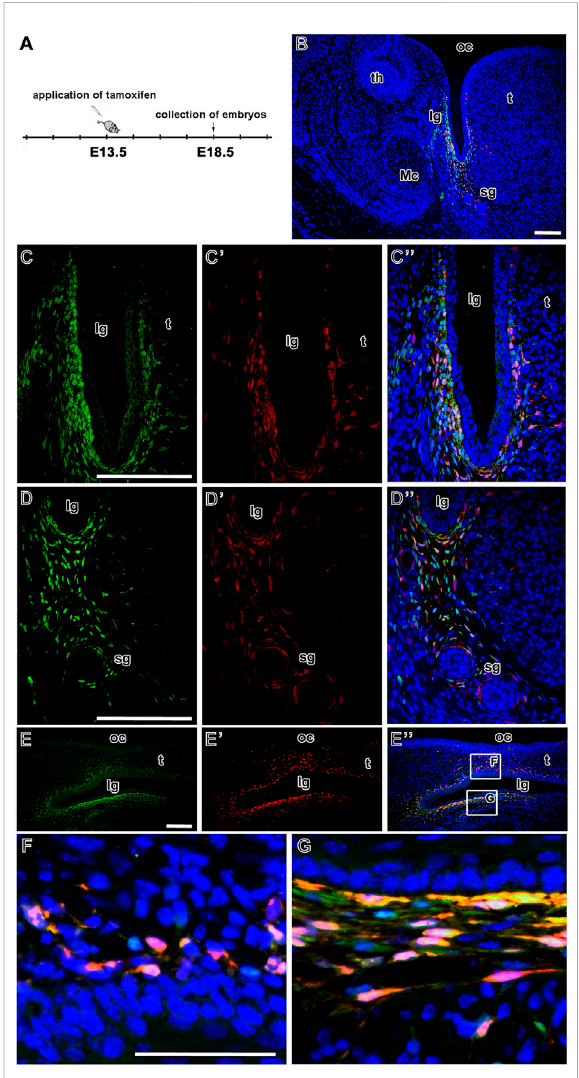
FIGURE 7 Fate of LGR5-positive cells during development of lingual groove. Timeline of tamoxifen induction and collection of embryos (A) . Low-magni fi cation image of the area of lingual groove after lineage tracing analysis. The overlap of LGR5/ EGFPpositivecells(greencolor)andLGR5/tdTomatopositivecells (red color) represented by yellow color (B) . Higher-magni fi cation of fate mapping of LGR5-positive cells (C-D´´) . The LGR5/EGFP positive cells are situated in the mesenchyme of labial side of the lingual groove, some of them are localized into the lingual side of groove (C,C´´) or they are spread up to the outlets of salivary glands (D,D´´) .TheLGR5/tdTomatopositivecellsaredistributedin thesimilarway,inthelabialandlingualmesenchymeofthegroove (C´,C´´) and in the mesenchyme around salivary glands (D´,D´´) . There is observed an overlap of LGR5/EGFP positive cells and LGR5/tdTomato positive cells in above mentioned regions (C´´,D´´) . The sagittal sections of lingual groove con fi rm distribution pattern of LGR5-positive cell in the area of lingual groove (E,E´,E´´ andindetail F,G) .lg,lingualgroove;Mc,Meckel´ s cartilage; oc, oral cavity; sg, salivary gland; t, tongue; th, tooth. Scale bars = 100 μ m.